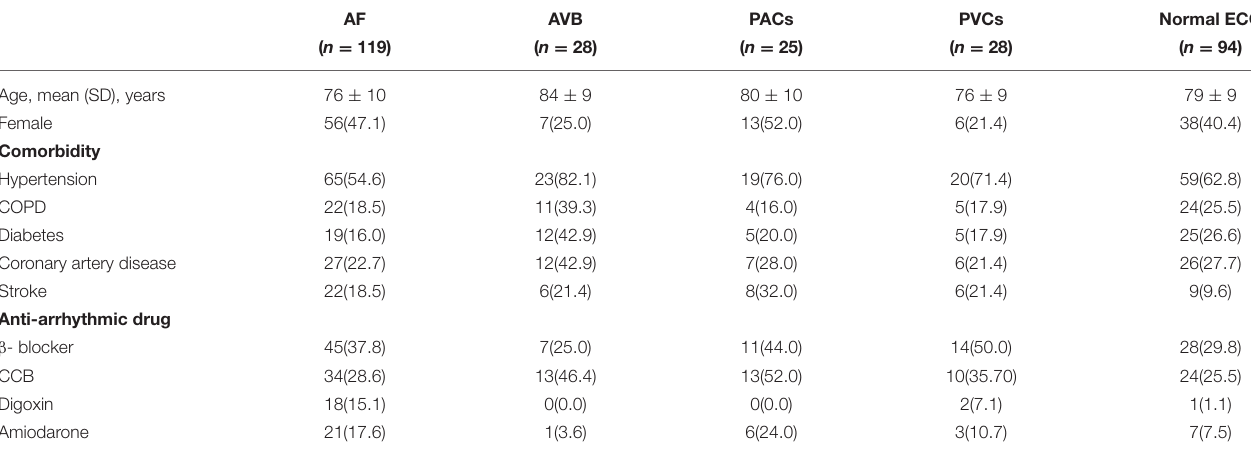
TABLE 1 | Baseline characteristics of the study population.